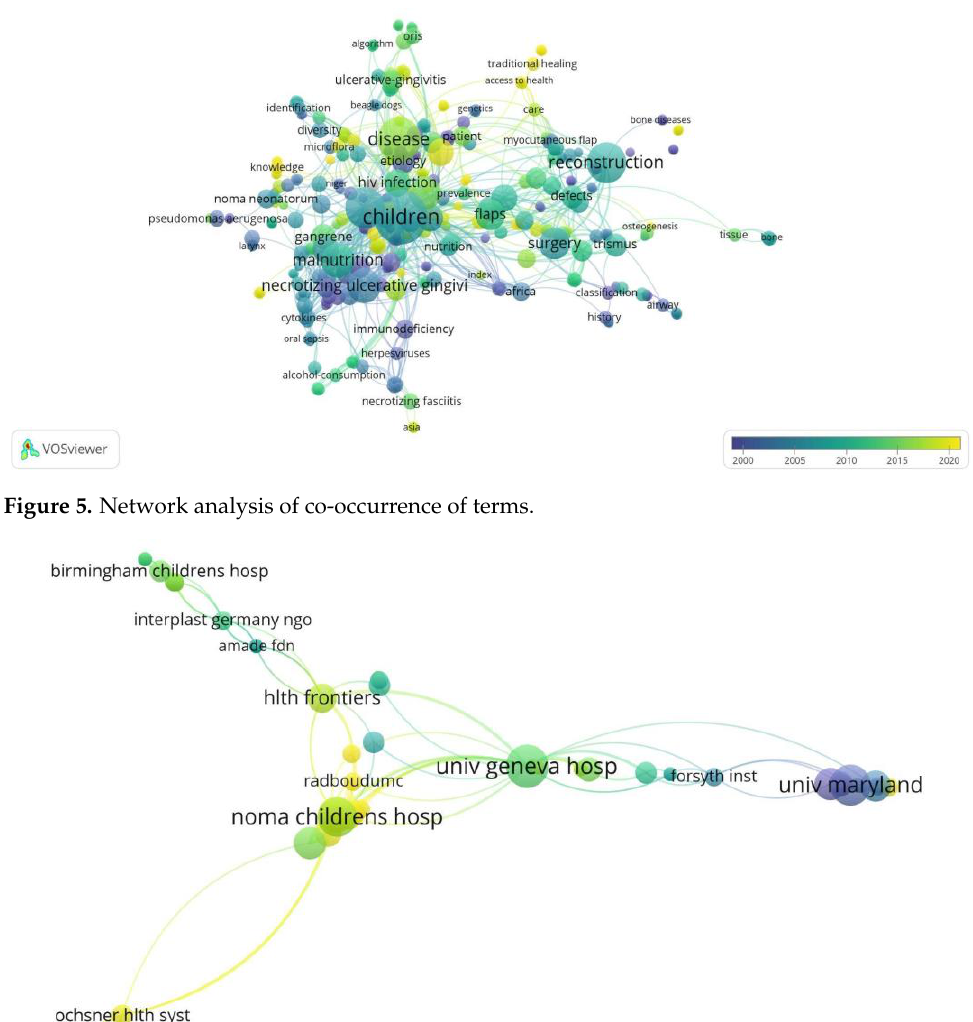
Figure 6. Network analysis of organization co-authorship.